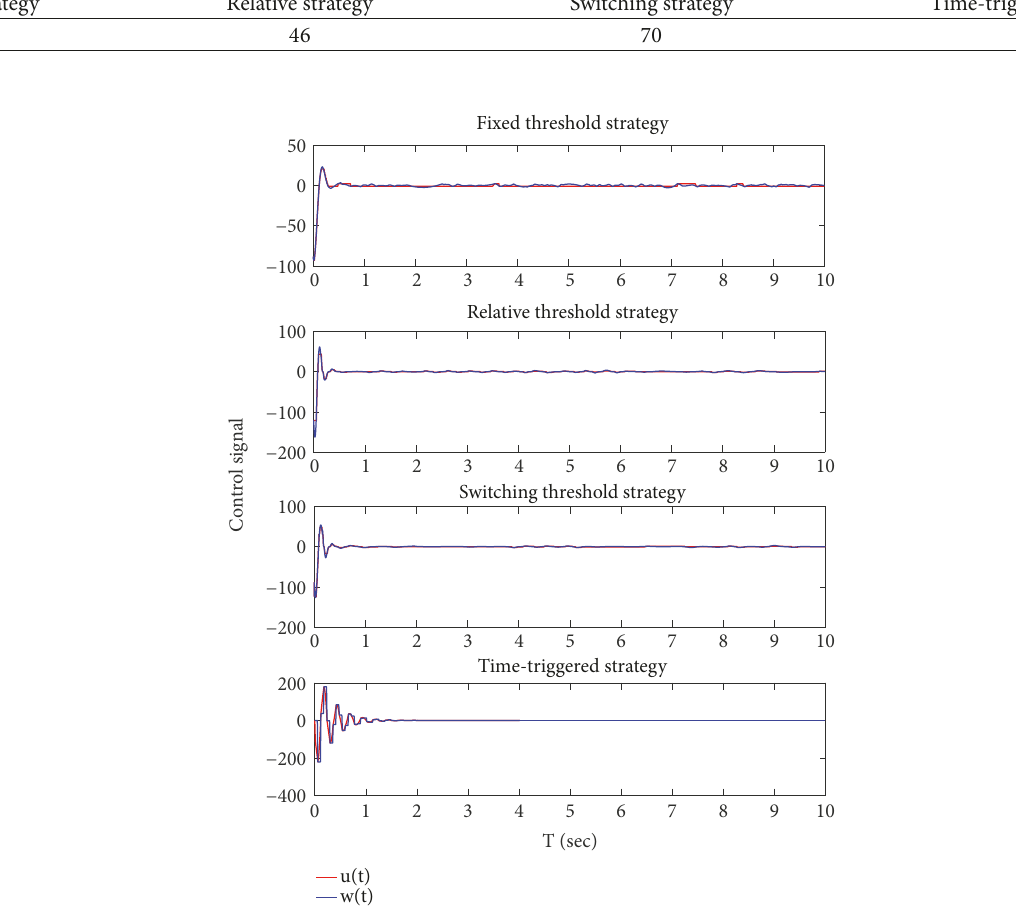
Figure 2: Control